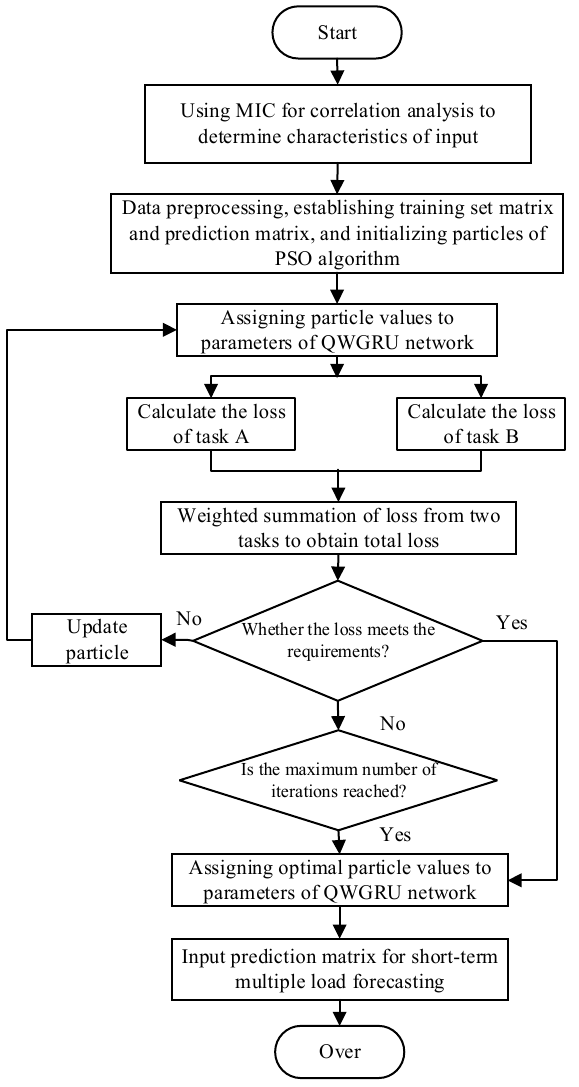
Figure 5. Flow chart of multiple short-term load forecasting.